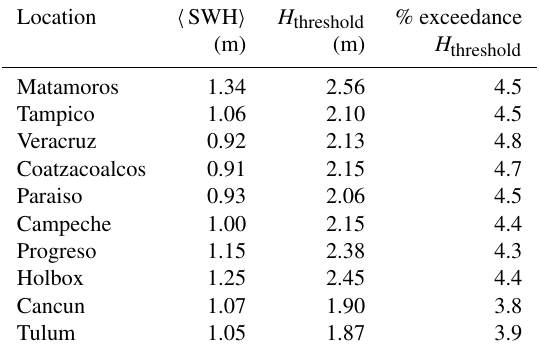
Figure 2. Monthly mean SWH for each studied node. Table 1. Average significant wave height, (cid:104) SWH (cid:105) ; critical thresh- old, H threshold ; and percentage of H threshold exceedance for each